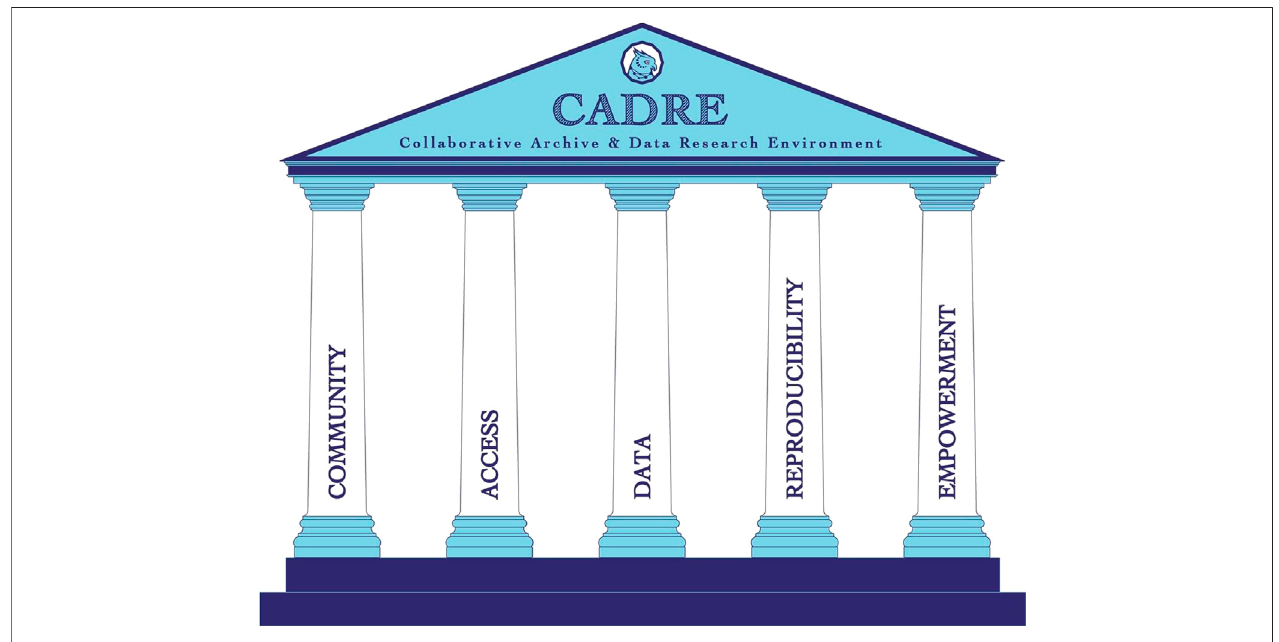
FIGURE 1 | The fi ve pillars of CADRE.